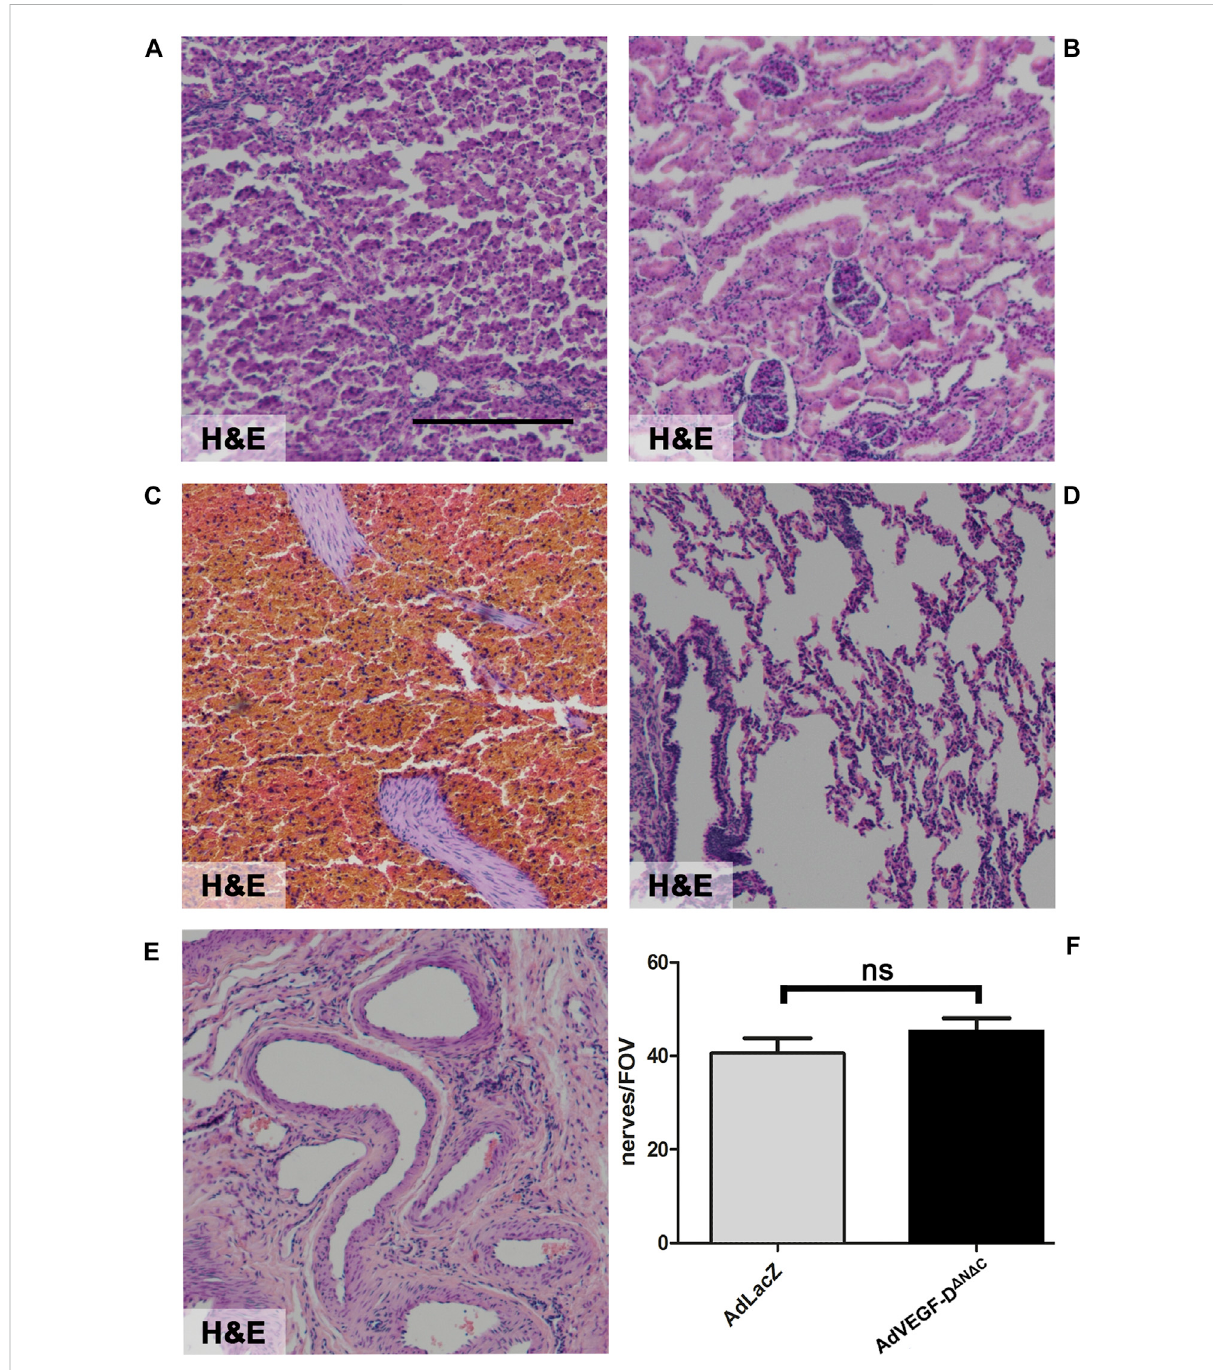
FIGURE 6 AdVEGF-D Δ N Δ C had no effect on off-target tissues or cardiac nerves. Gene transfer of AdVEGF-D Δ N Δ C did not affect off-target tissue